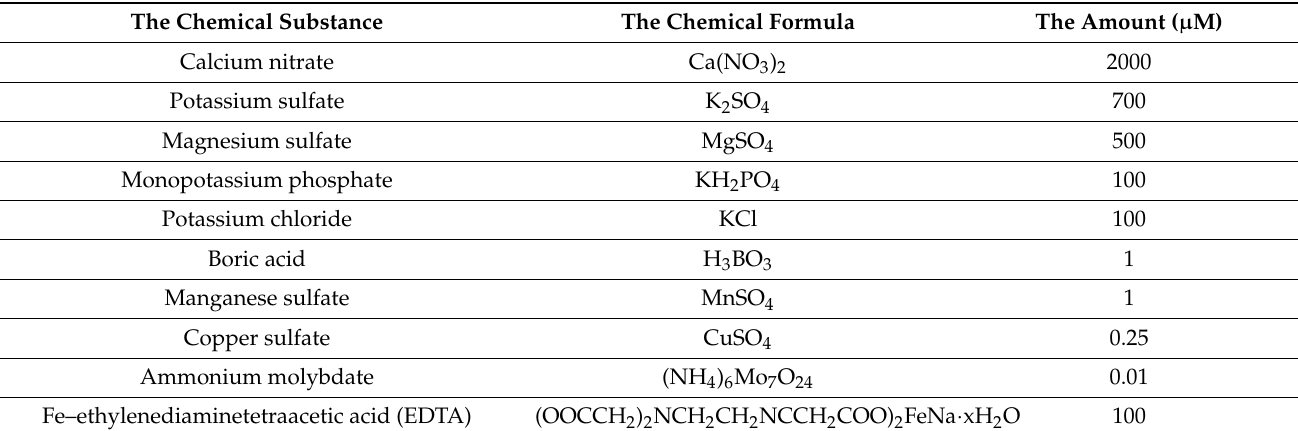
Table 1. The nourishing solution composition prepared for watering maize